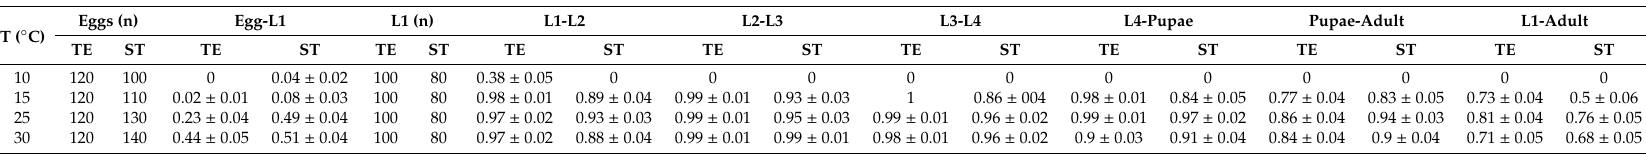
Table 1. Temperate Ae. albopictus immature survival. Survival rate (as fraction), with standard error, from hatching to emergence of temperate (TE) and subtropical (ST) Ae. albopictus maintained at four constant temperatures: 10, 15, 25, and 30 ◦ C.